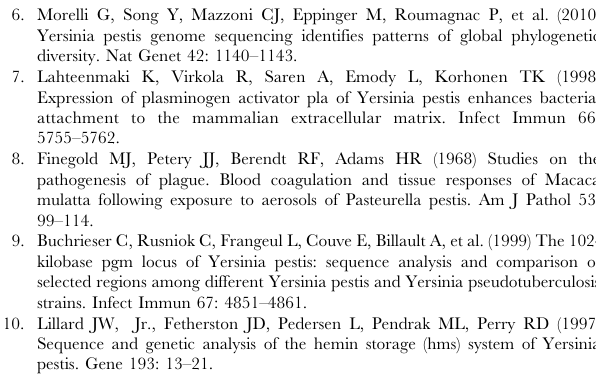
Table S1 List of primers used to validate SNPs and INDELs in Yersinia pestis KIM10 and KIM D27.